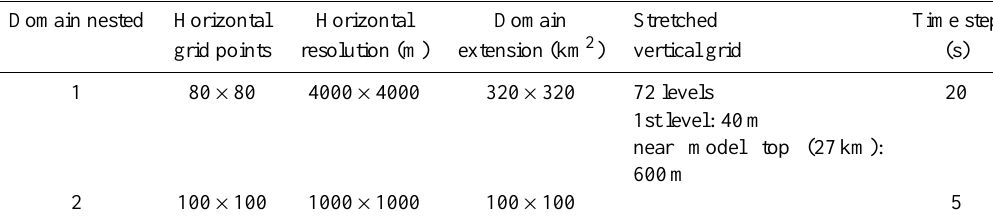
Table 1. Model nesting configuration for